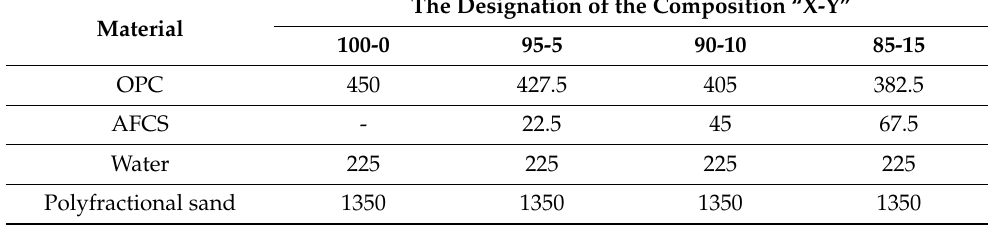
Table 3. Compositions of the mixed cements (mass,